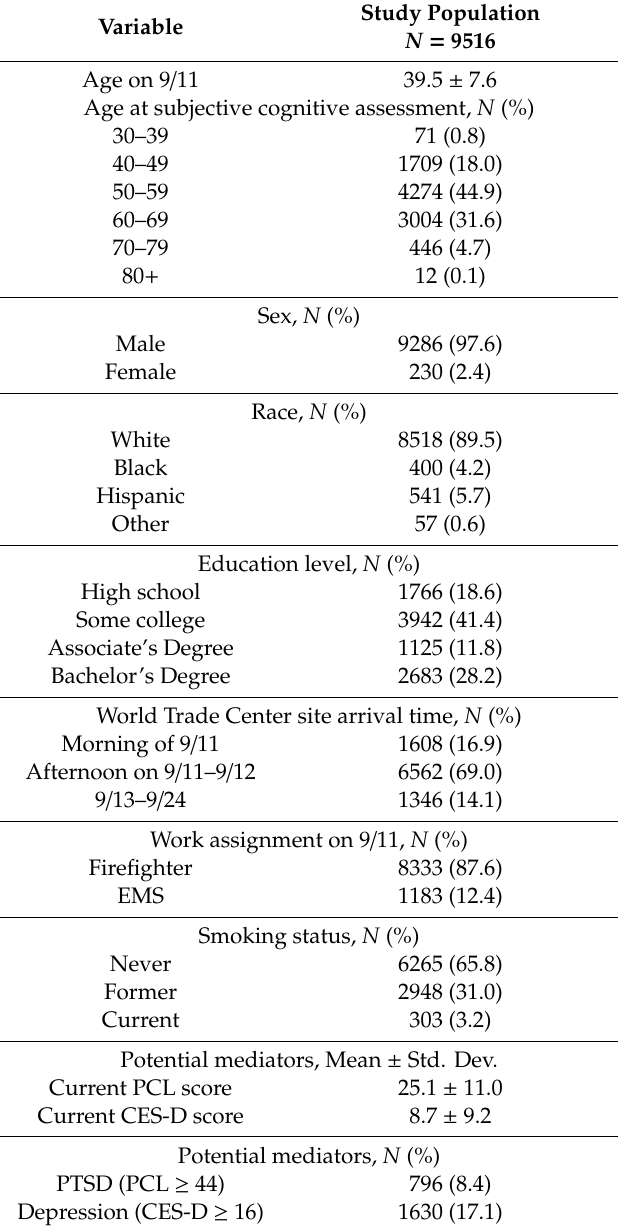
Table 1. Population